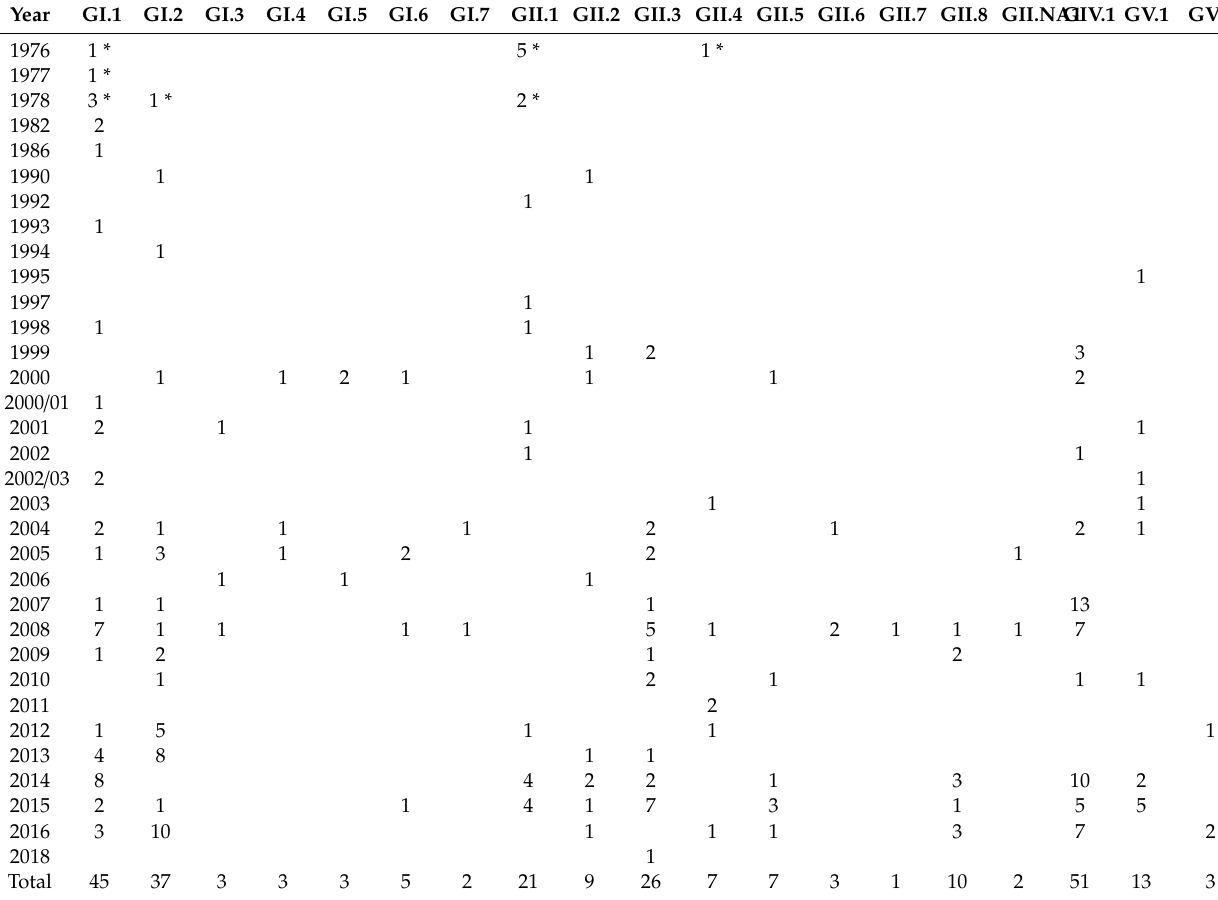
Table 1. The number of sapovirus sequences newly obtained or retrieved from public repositories for this study, for each genotype on the corresponding year of their